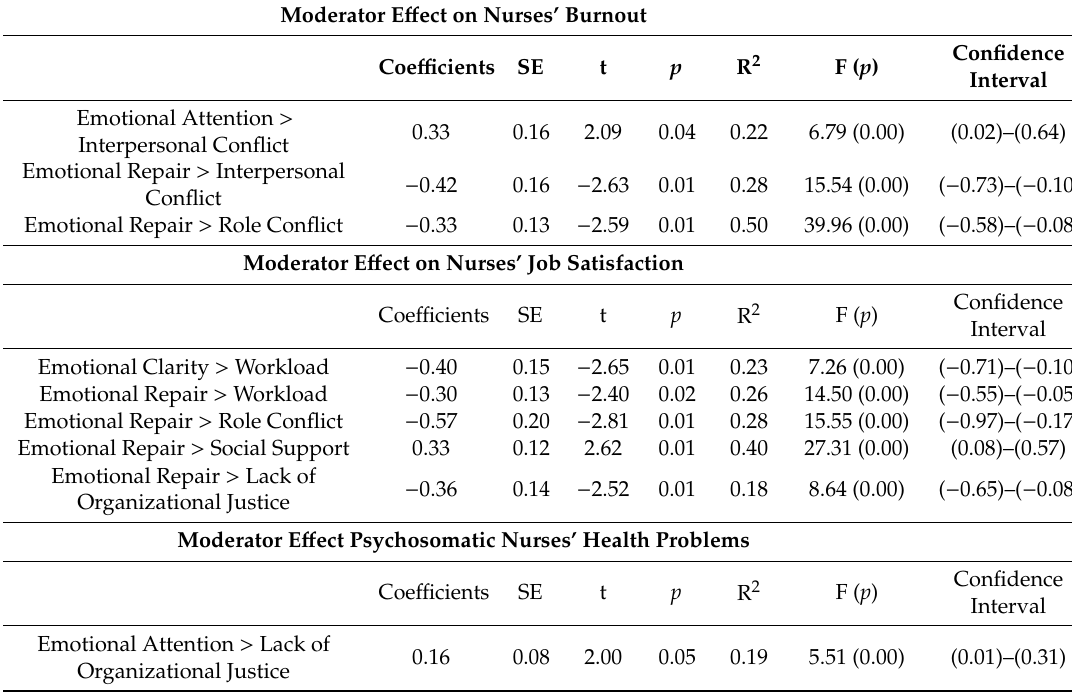
Figure 3. Moderation of emotional intelligence on the effect of psychosocial risks on psychosomatic health problems. Table 2. Moderation of emotional intelligence on the effect of psychosocial risks on burnout, job satisfaction, and psychosomatic health problems.